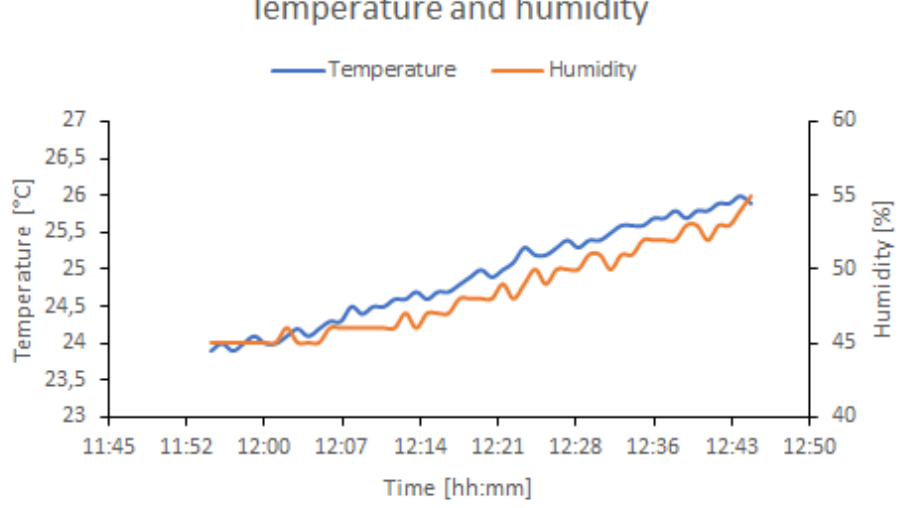
Figure 2. Temperature and humidity in the